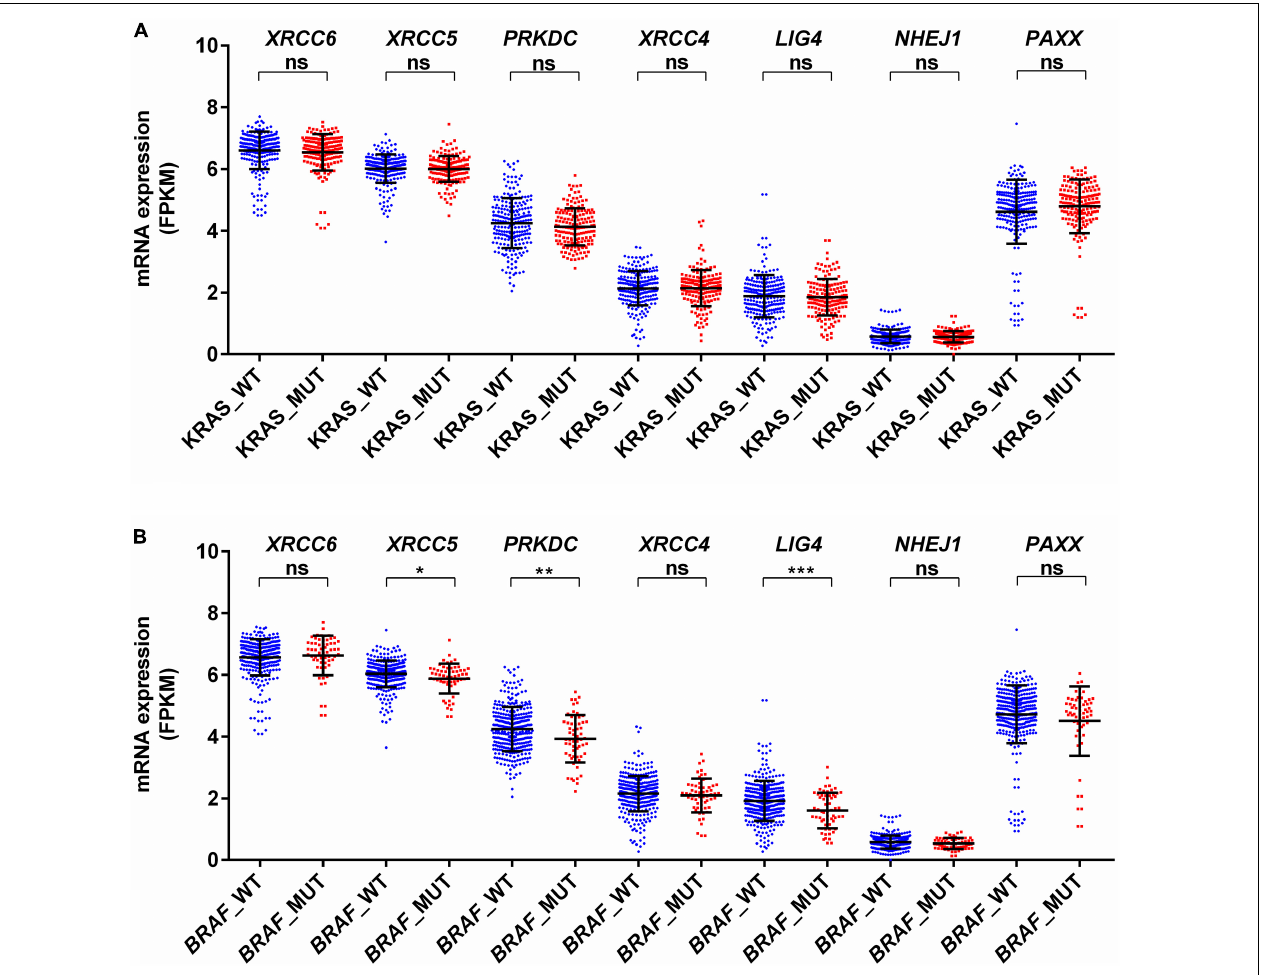
FIGURE 4 | Association of mRNA expression of NHEJ pathway genes with (A) KRAS mutation status, and (B) BRAF mutation status. * p < 0.05, ** p < 0.01, *** p < 0.001, **** p < 0.0001. FPKM, Fragments per kilo million bases. WT, wild type; MUT, mutant.